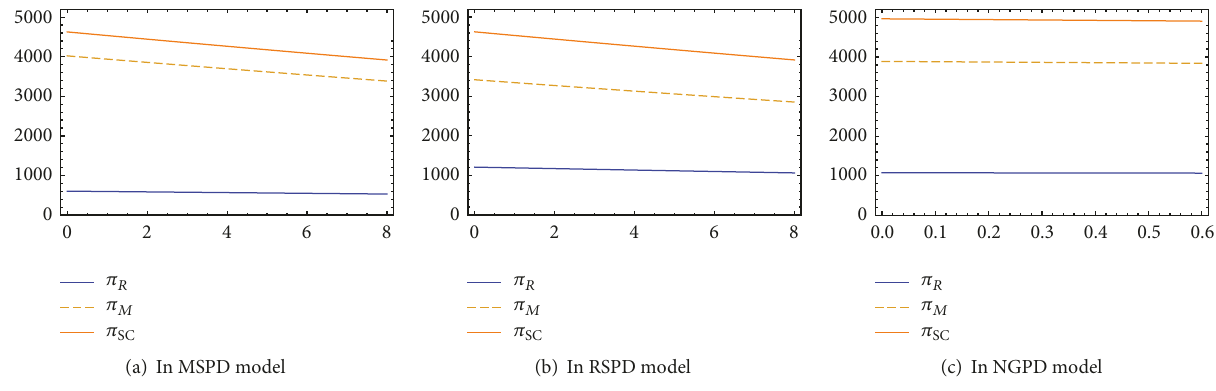
Figure 4: The change of expected profits with the parameters 𝑞 𝑟